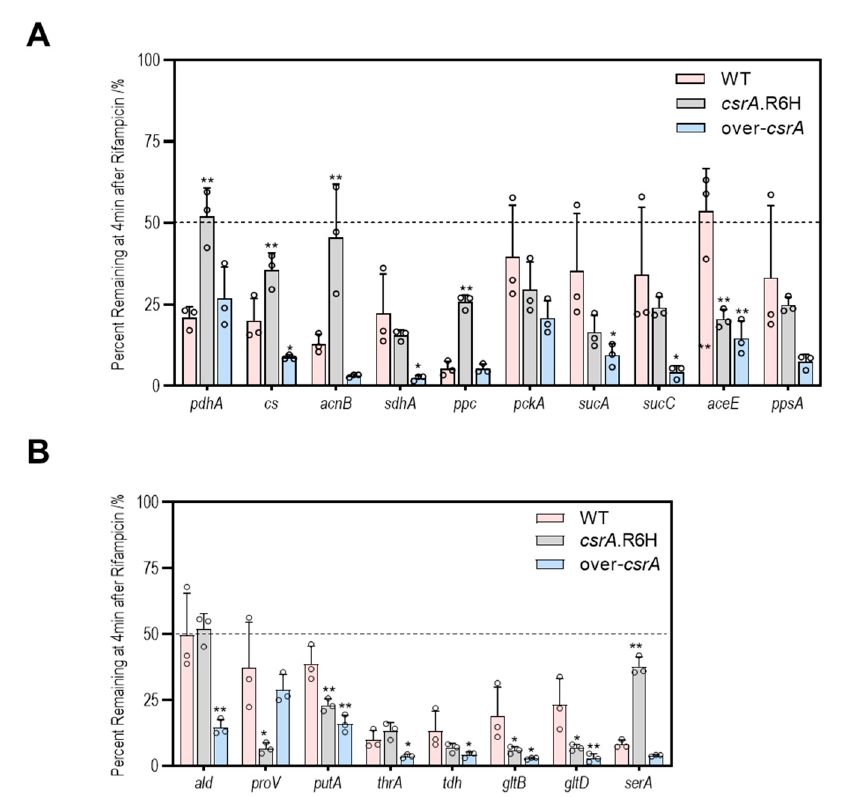
Figure 8. CsrA changes the transcript abundance of genes involved in central metabolism, likely by alternation of their mRNA stability. ( A ) The percent remaining at 4 min after rifampin addition. The rates of decay for pdhA , cs , acnB , sdhA , ppc , pckA , sucA , sucC , aceE , and ppsA (which were up-regulated or downregulated significantly and displayed greater than 3-fold changes in expression in the csrA mutant or over csrA strain compared with the wild-type strain) was measured by qRT-PCR from wild-type, csrA .R6H, or over- csrA cells grown to the mid-log phase (OD600 ~0.5) in LBS medium. ( B ) Percent remaining at 4 min after rifampin addition. The rates of decay for ald , proV , putA , thrA , tdh, gltB , gltD , and serA (which were up-regulated or downregulated significantly and displayed greater than 2-fold changes in expression in the csrA mutant or over csrA strain compared with the wild-type strain) were measured by qRT-PCR from wild-type, csrA .R6H, and over- csrA cells grown to the mid-log phase (OD600 ~0.5) in LBS medium. Rifampin was added to stop transcription, and cells were harvested immediately (t = 0) and at 4 min after rifampin addition. The displayed values correspond to the percentage of RNA remaining at 4 min after rifampin addition in data showing the degree of RNA decay. The error bars are the standard deviations, and the p values were calculated using one-way ANOVA ( p values: *, <0.05, **, <0.01), comparing the ZJ_T- csrA R6H and overexpression strains to the wild